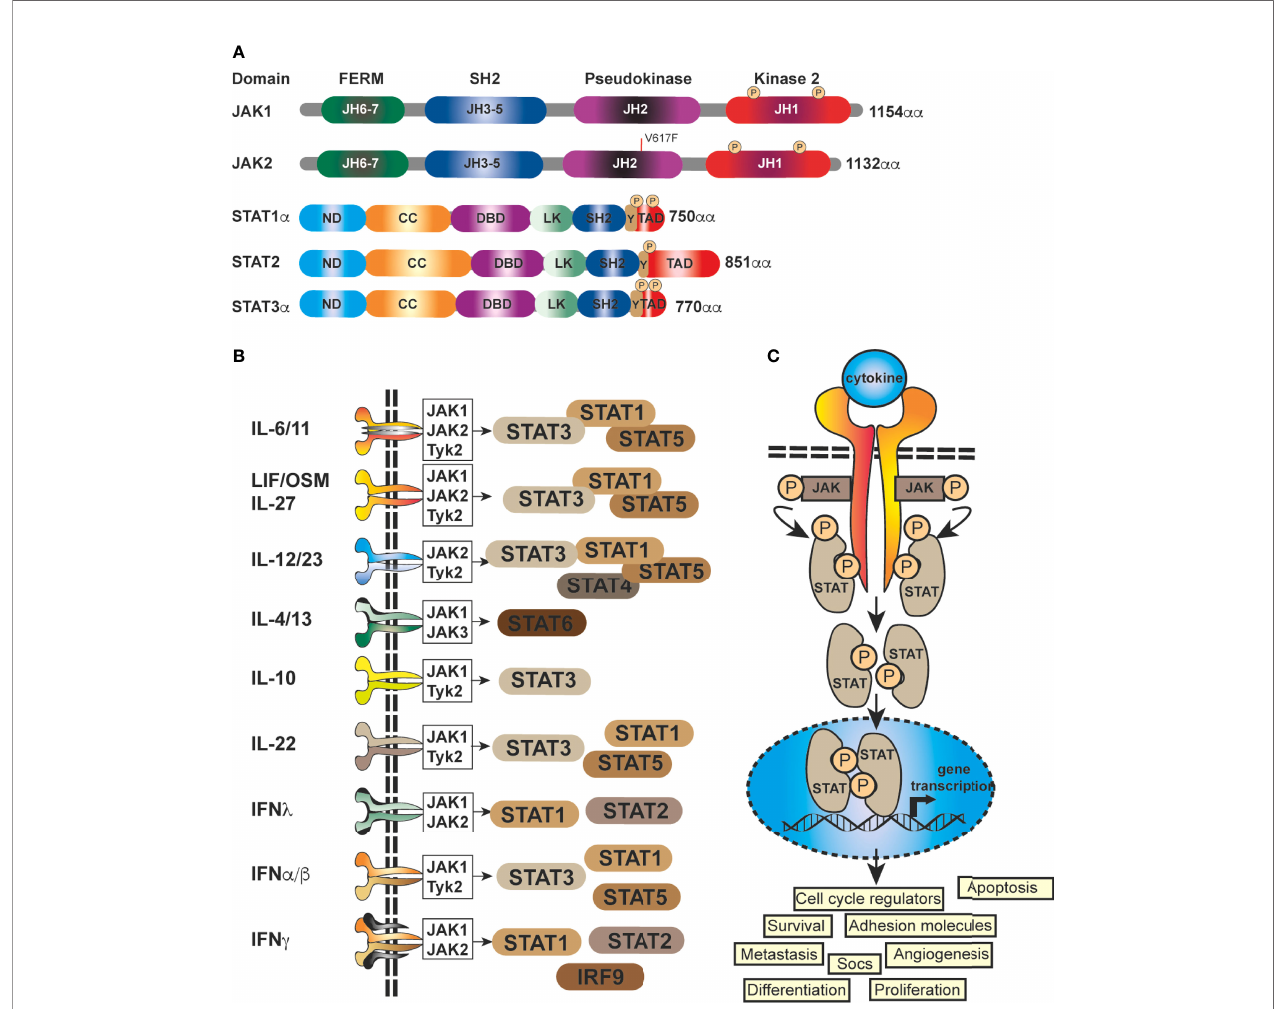
FIGURE 1 | Schematic representation of the generic domain structure of JAKs and STATs. (A) Functional domains of the most important human JAKs and STATs regulating the progression of solid malignancies; ND, N-terminal; CC, coiled-coil; DBD, DNA-binding; LK, linker; SH2, Src-homology; TAD, transcriptional activation domain; JH1, kinase; JH2, pseudo-kinase domain with the ezrin, radixin, moesin (FERM) and SH2 domains forming a JAK receptor-binding module and the PK domain restrains Tyr kinase activity by binding the kinase domain. The common V617F mutation in JAK2 is shown (red line). (B) STATs are activated by a multitude of cytokines and IFNs. The most important ligands, receptors and pairing of JAKs regulating the progression of solid malignancies are shown. Shared receptor subunits are indicated by identical coloring. (C) Simpli fi ed schematic representation of the JAK-STAT signaling pathway. JAK activation occurs upon the binding of ligand and receptor multiprotein assembly, at which point two JAKs are brought into close proximity, permitting trans-phosphorylation. Once activated, the JAKs are capable of phosphorylating further targets, fi rstly the intracellular tails of the receptors on speci fi c tyrosines, which then act as docking sites for their preferred substrates, the STAT proteins. Each STAT contains a conserved tyrosine residue near to the C- terminus transactivation domain (TAD), which is phosphorylated by the JAK proteins. This phospho-tyrosine promotes STAT protein dimerization via binding of an adjacent SRC homology 2, (SH2) domain and leads to exposure of a nuclear localisation signal (NLS), translocation into the nucleus, where they activate the transcription of genes involved in many cellular